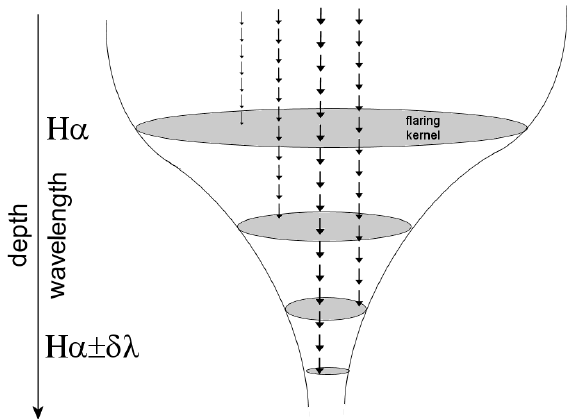
Fig. 7. Plasma located on various depths in the lower part of the magnetic loops is excited and heated by non-thermal electrons of various energies. Due to the cone-shaped lower part of the loop, the actual size of the flaring kernel will depend on the wavelength in a frame of the H α line